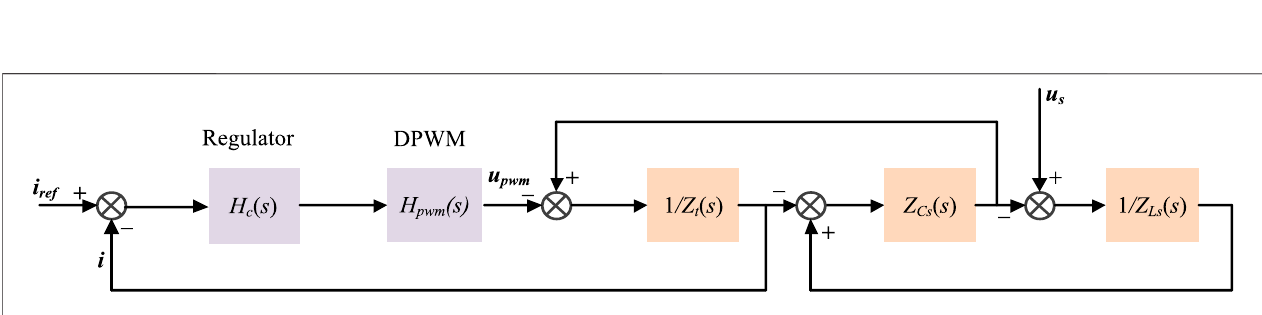
FIGURE 5 | The block diagram of the current controller of the VSC.